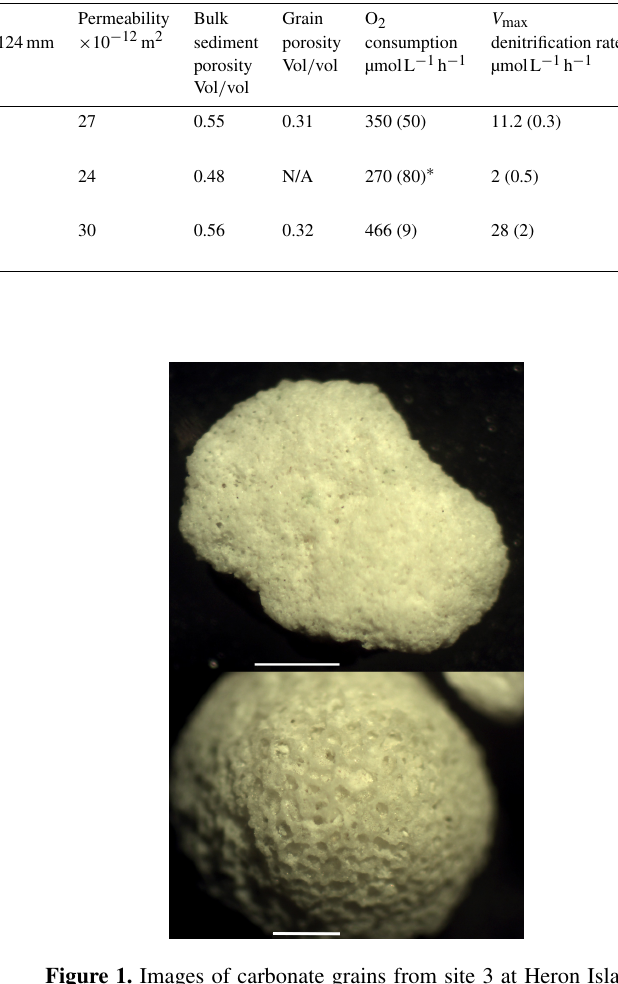
Table 1. Sediment grain size, permeability, grain porosity and sediment oxygen consumption rate (with SD) at the three study sites. O 2 consumption and denitrification rates are from flow-through reactor experiments.